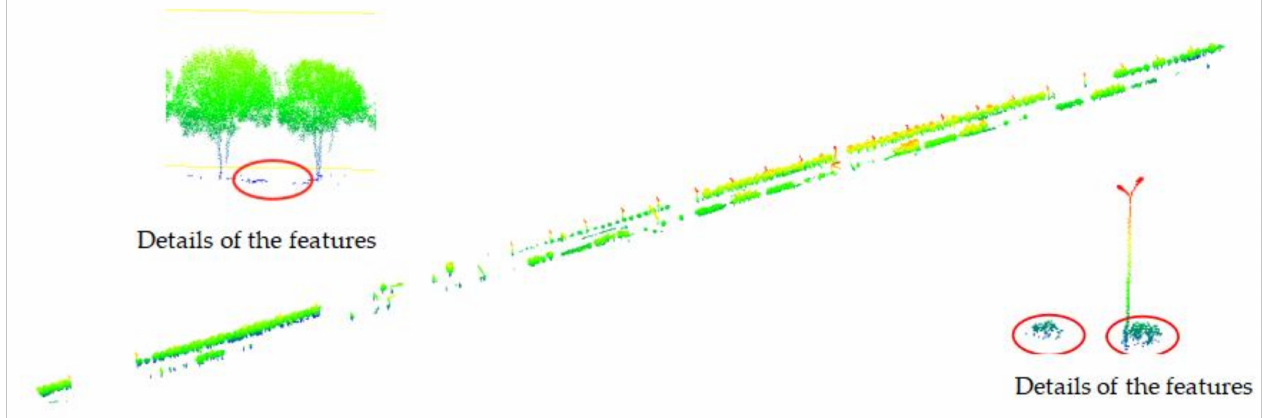
Figure 6. Extracted pole-like object point